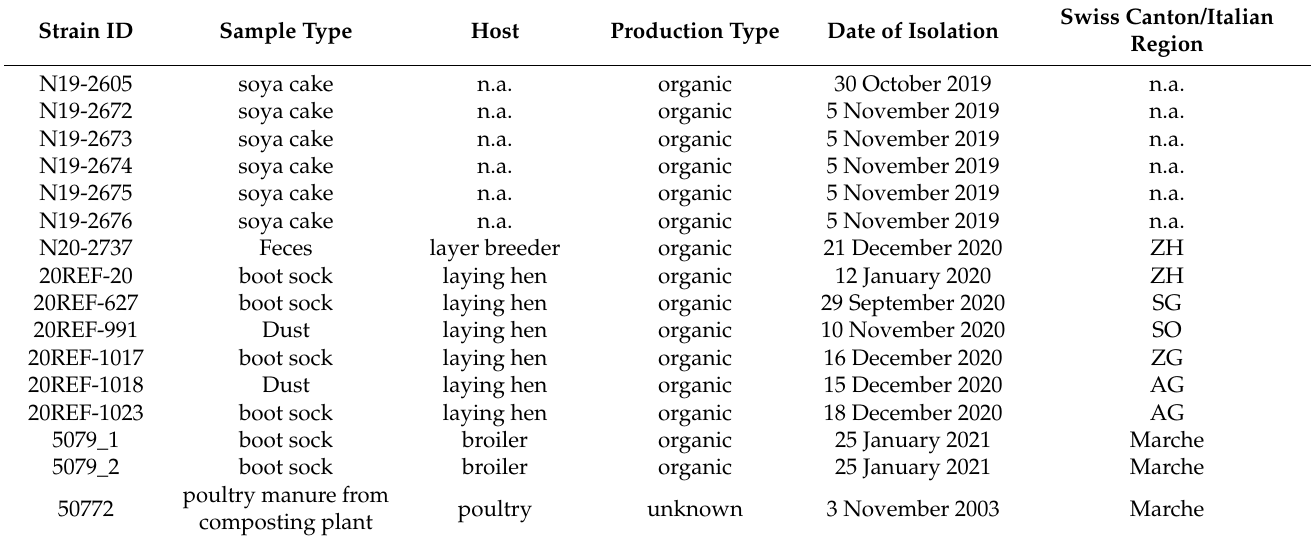
Table 1. Origin of the Salmonella Jerusalem